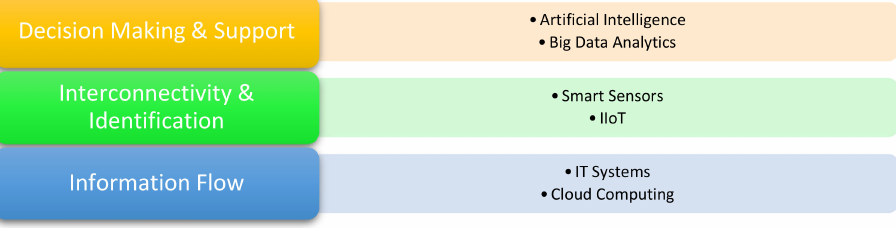
Figure 8. Industry 4.0 technologies applied to Logistics [32,33].